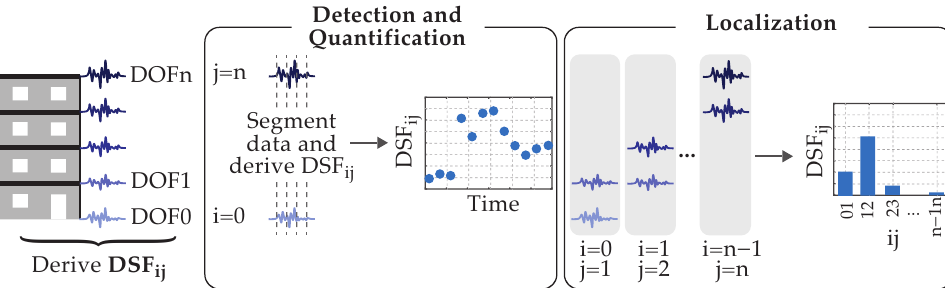
Figure 1. DSFs are extracted from vibration-based monitoring data and allow for detection of the onset of damage and the quantification of its severity over time. In addition, multiple sensors enable the definition of substructures through sensor pairs and consequently convey information regarding the location of